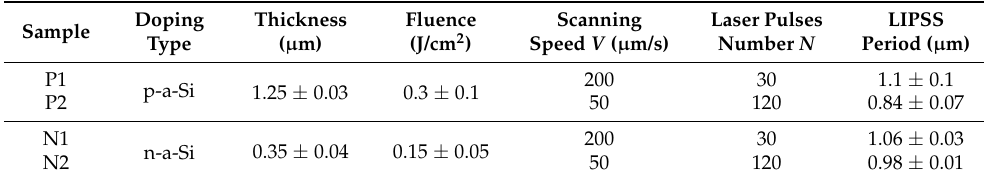
Table 1. Sample preparation parameters and formed LIPSS